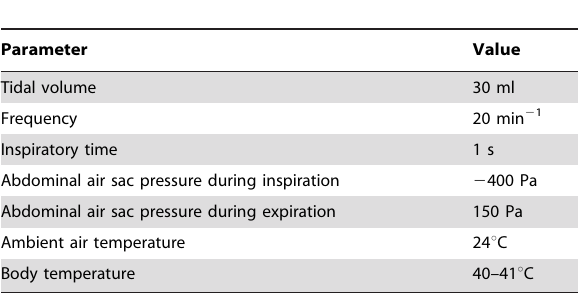
Table 2. Published respiratory parameters for the domestic fowl with mean weight 1900 g from Bouverot and Dejours